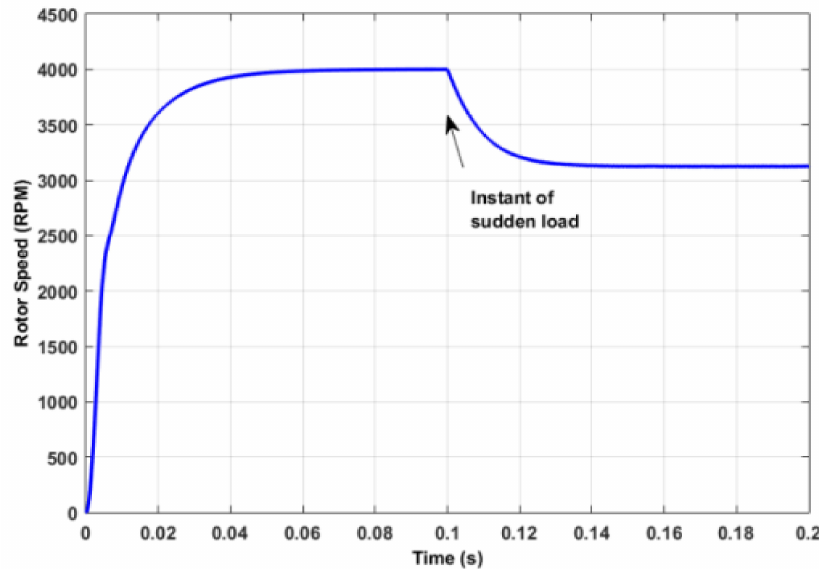
Figure 2. Open-loop response of BLDC motor drive system